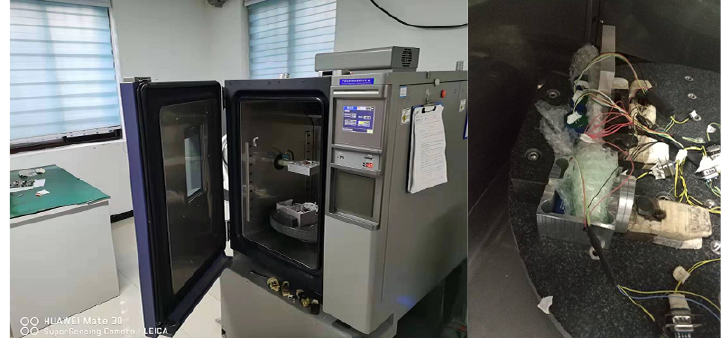
Figure 2. Thermal calibration experimental equipment.